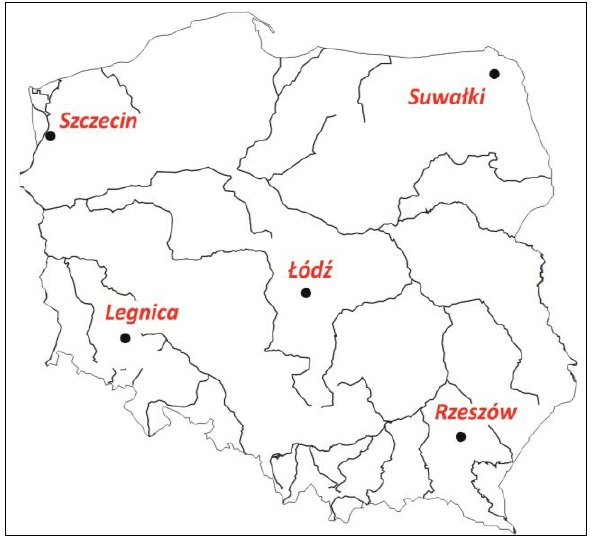
Fig. 1. Meteorological stations used in the